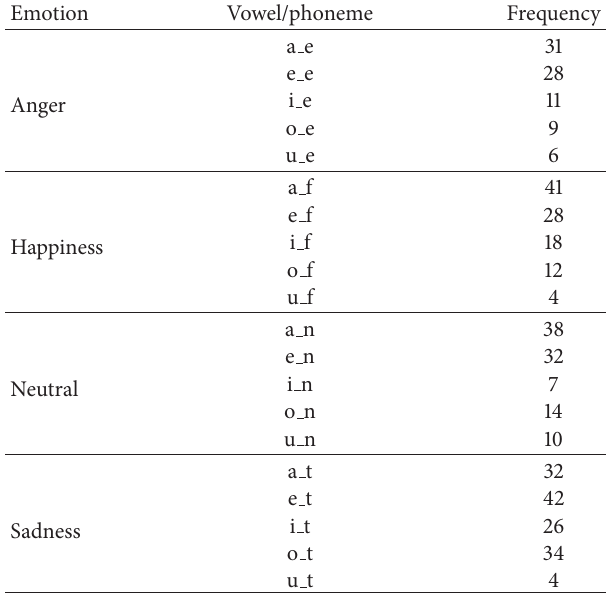
Table 6: Emotion-specific vowels in the emotional stimuli.